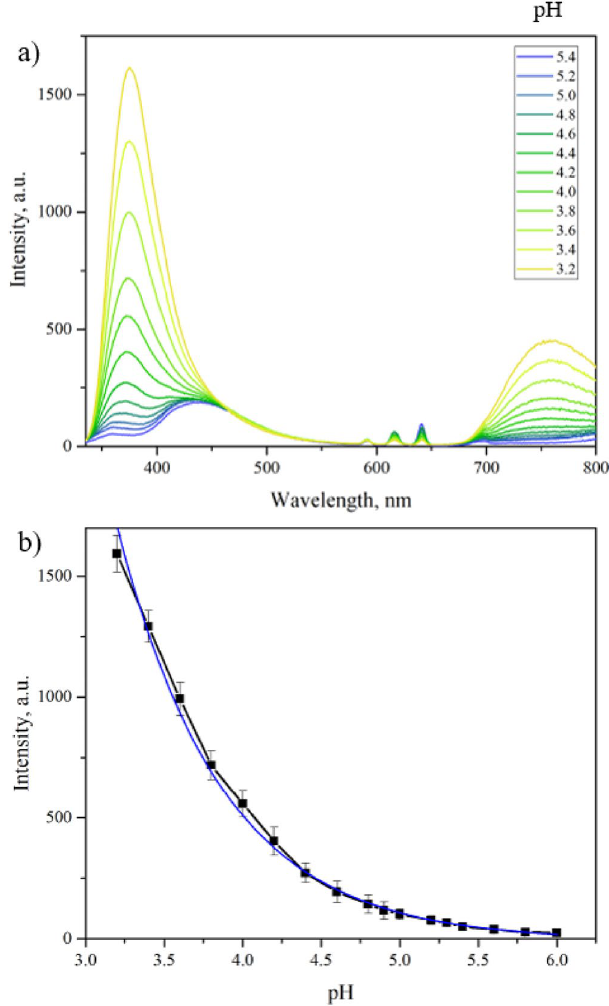
Figure 3. Fluorescence intensity changes (λ exc = 320 nm) of EuBDC-OMe MOF particle suspensions in water at acidic pH: ( a ) fluorescence emission spectra changes with decrease in pH; ( b ) peak 375 nm intensity change corresponding to decrease in pH (MOF suspension in water pH = 5.4). Error bars represent ± standard deviation (n =